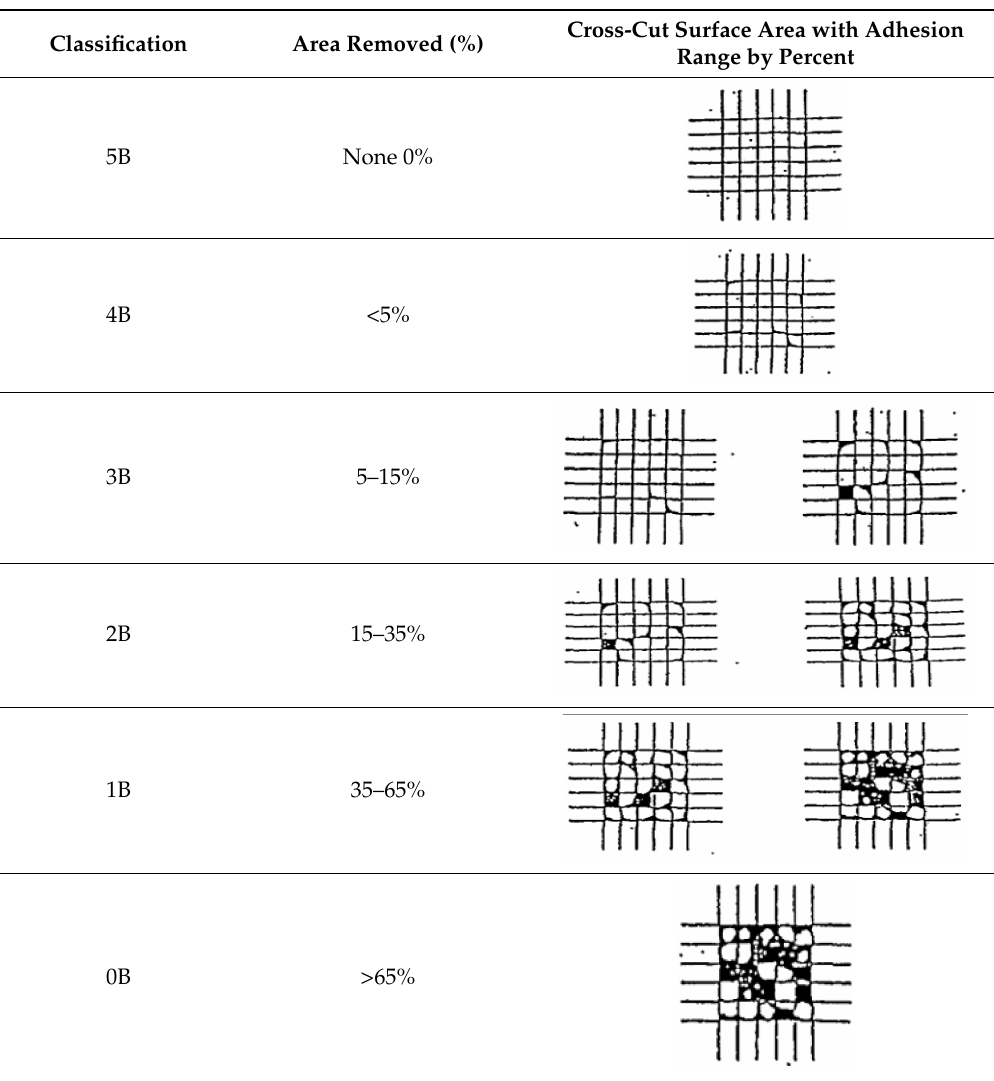
Table 2. Detachment patterns and classification of different coated surfaces after the adherence test (Modified from ASTM-3359-02 classification